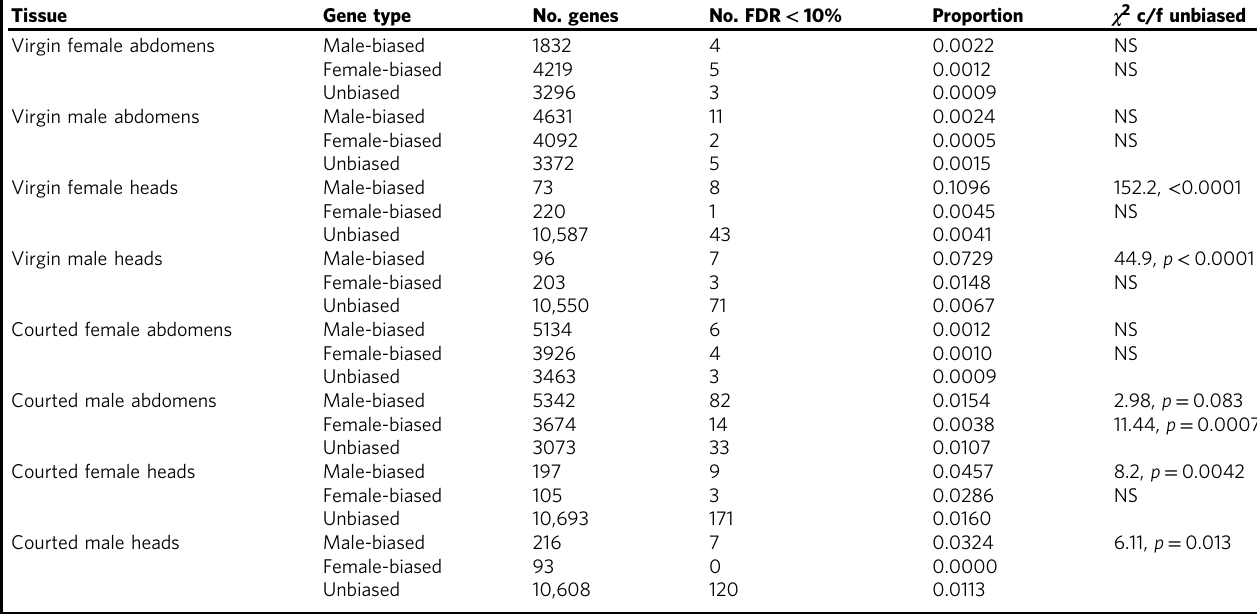
Table 1 Summary of χ 2 tests on 10% FDR DE genes in each of the eight possible sexual selection contrasts combining tissue, sex and courtship